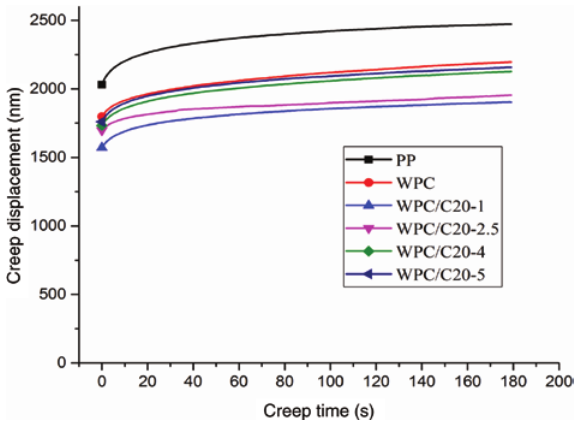
Figure 3: Creep displacement rate versus creep time for PP, WPC and WPC/C20 with different organoclay